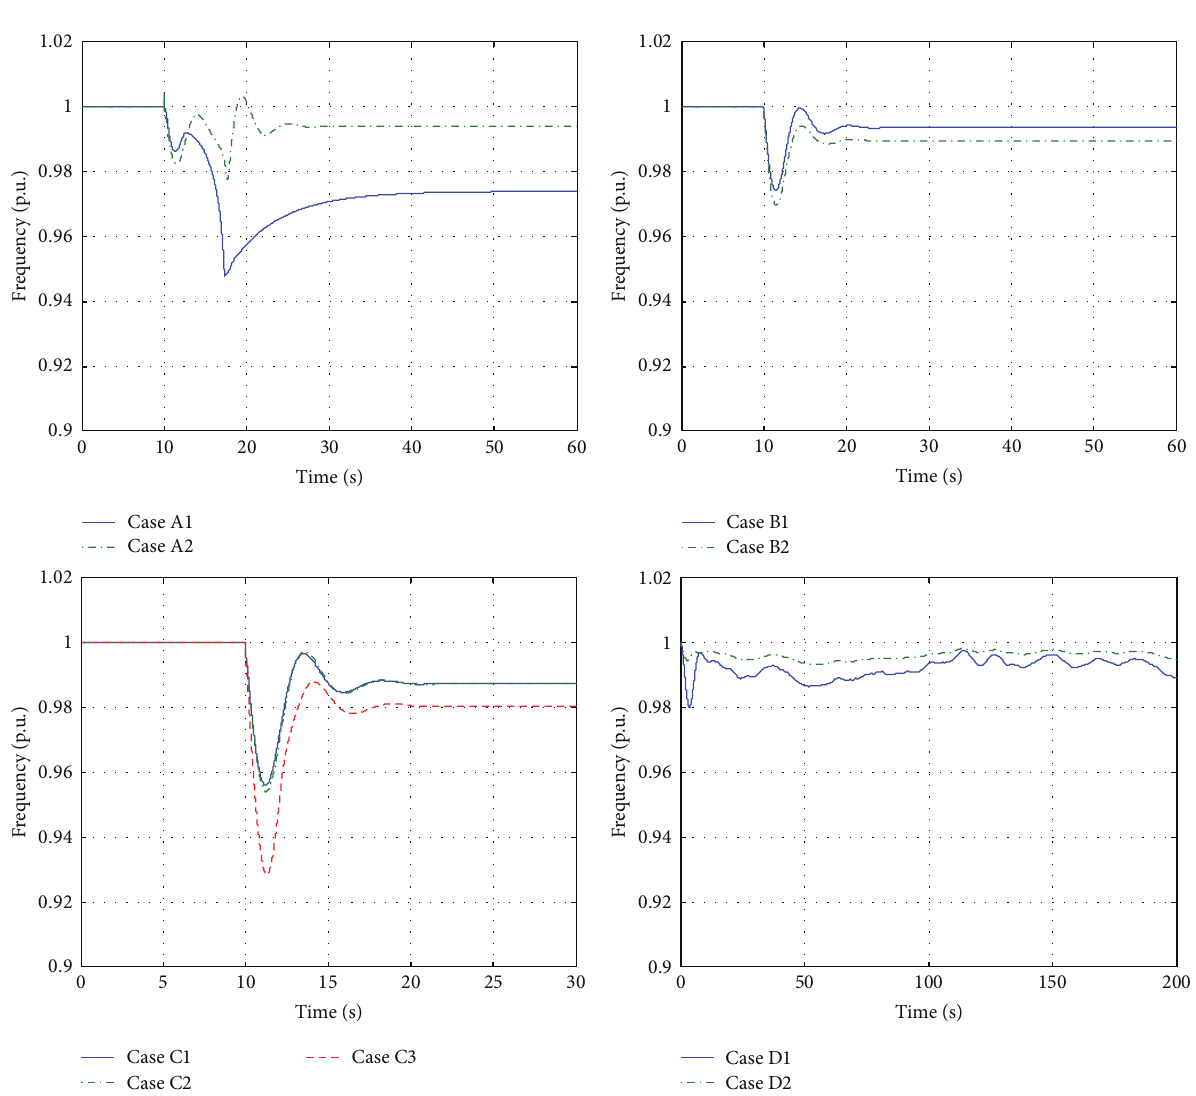
Figure 7: Frequency variations under transient conditions for the 9 simulation